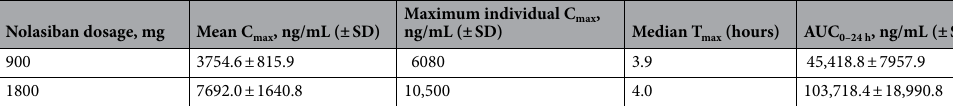
Nolasiban dosage,